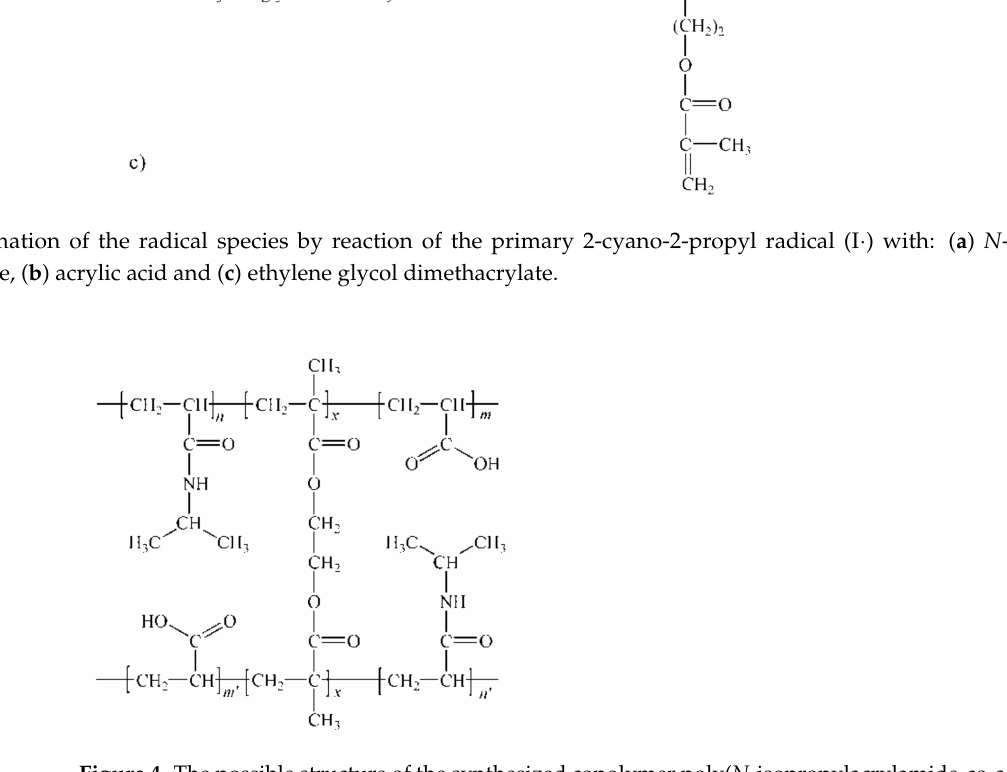
Figure 4. The possible structure of the synthesized copolymer poly( N -isopropylacrylamide-co-acrylic acid),